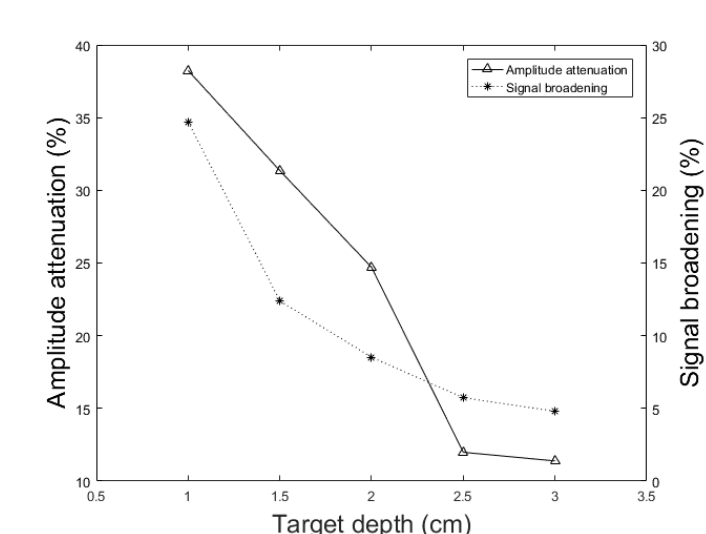
Figure 11. Simulation results of the effect of different target locations on the PA peak signal amplitude attenuation (solid line) and signal broadening (dotted line). In these simulations, the setup in Figure 2 with the parameters, h = 7 mm, k = 10 mm, r 0 = 1 mm, r d = 0.25 inch, and T = 5 cm is used. The imaging target is moved away from the inner-skull surface from 1 cm to 3